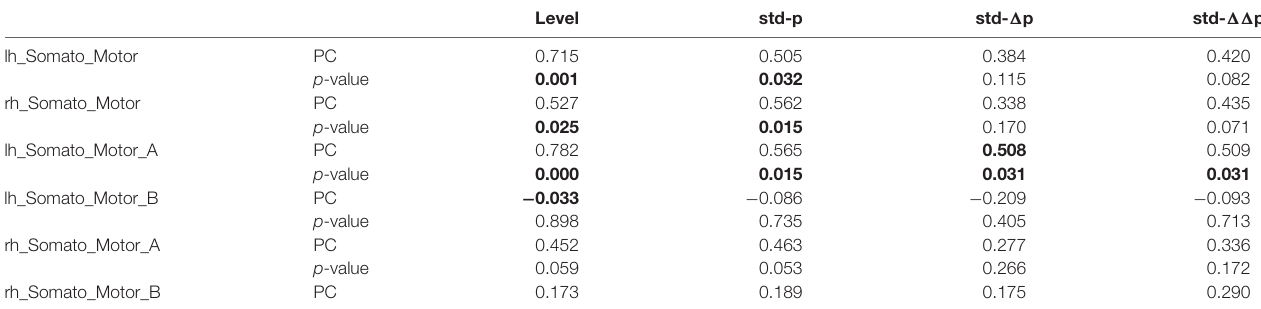
TABLE 5 | Pearson’s partial correlation analysis with brain volume correction for the Yeo networks in the cerebellum; significant values for p -value < 0.01 and p -value < 0.05 (bilateral). Level std-p std- ∆ p std- ∆∆